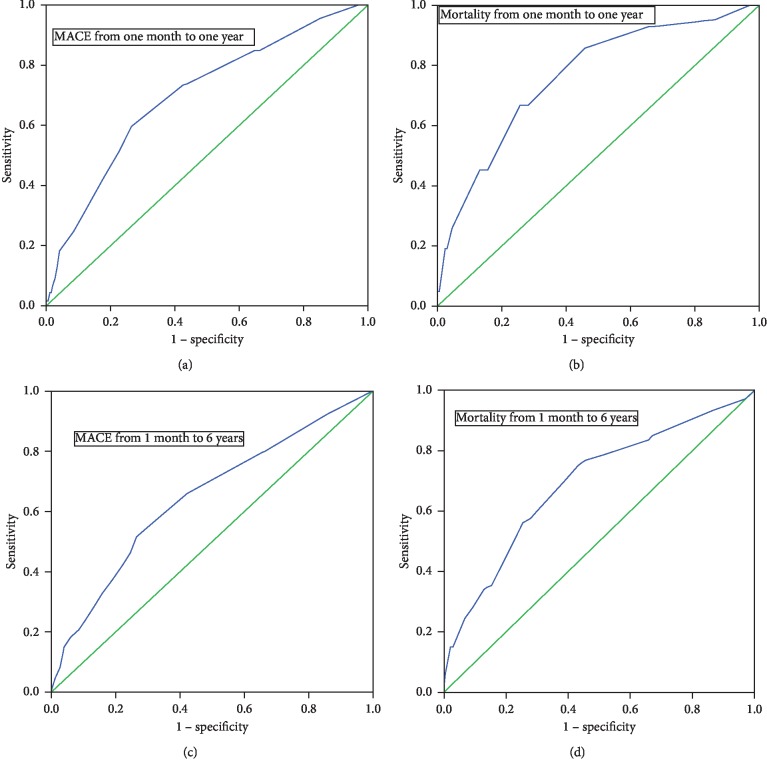
The ROC curves of the RISK-PCI score in predicting MACE and mortality from one months to one year (curves a and b) and from one month to six years (curves c and d). (a) AUC 0.71, 95% CI 0.66–0.75, p < 0.001. (b) AUC 0.76, 95% CI 0.68–0.84, p < 0.001. (c) AUC 0.65, 95% CI 0.61–0.71, p < 0.001. (d) AUC 0.71, 95% CI 0.63–0.76, p < 0.001.